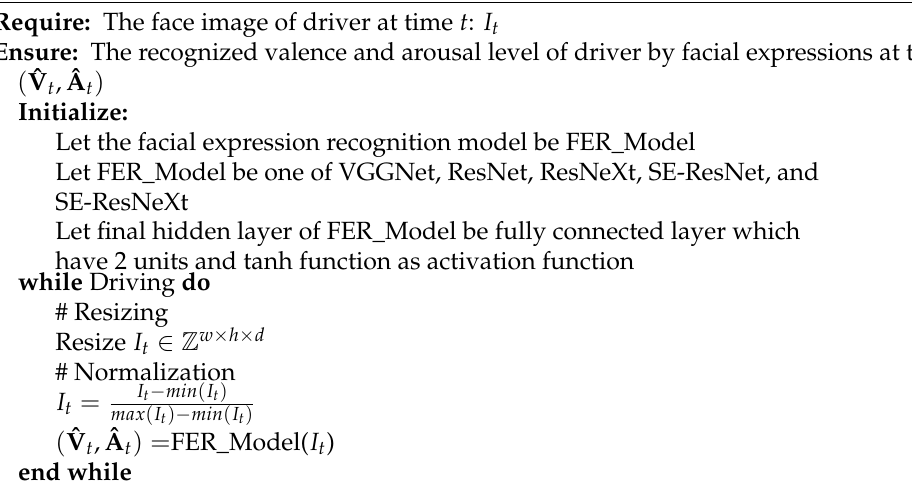
Algorithm 1 Our Facial Expression Recognition (FER)